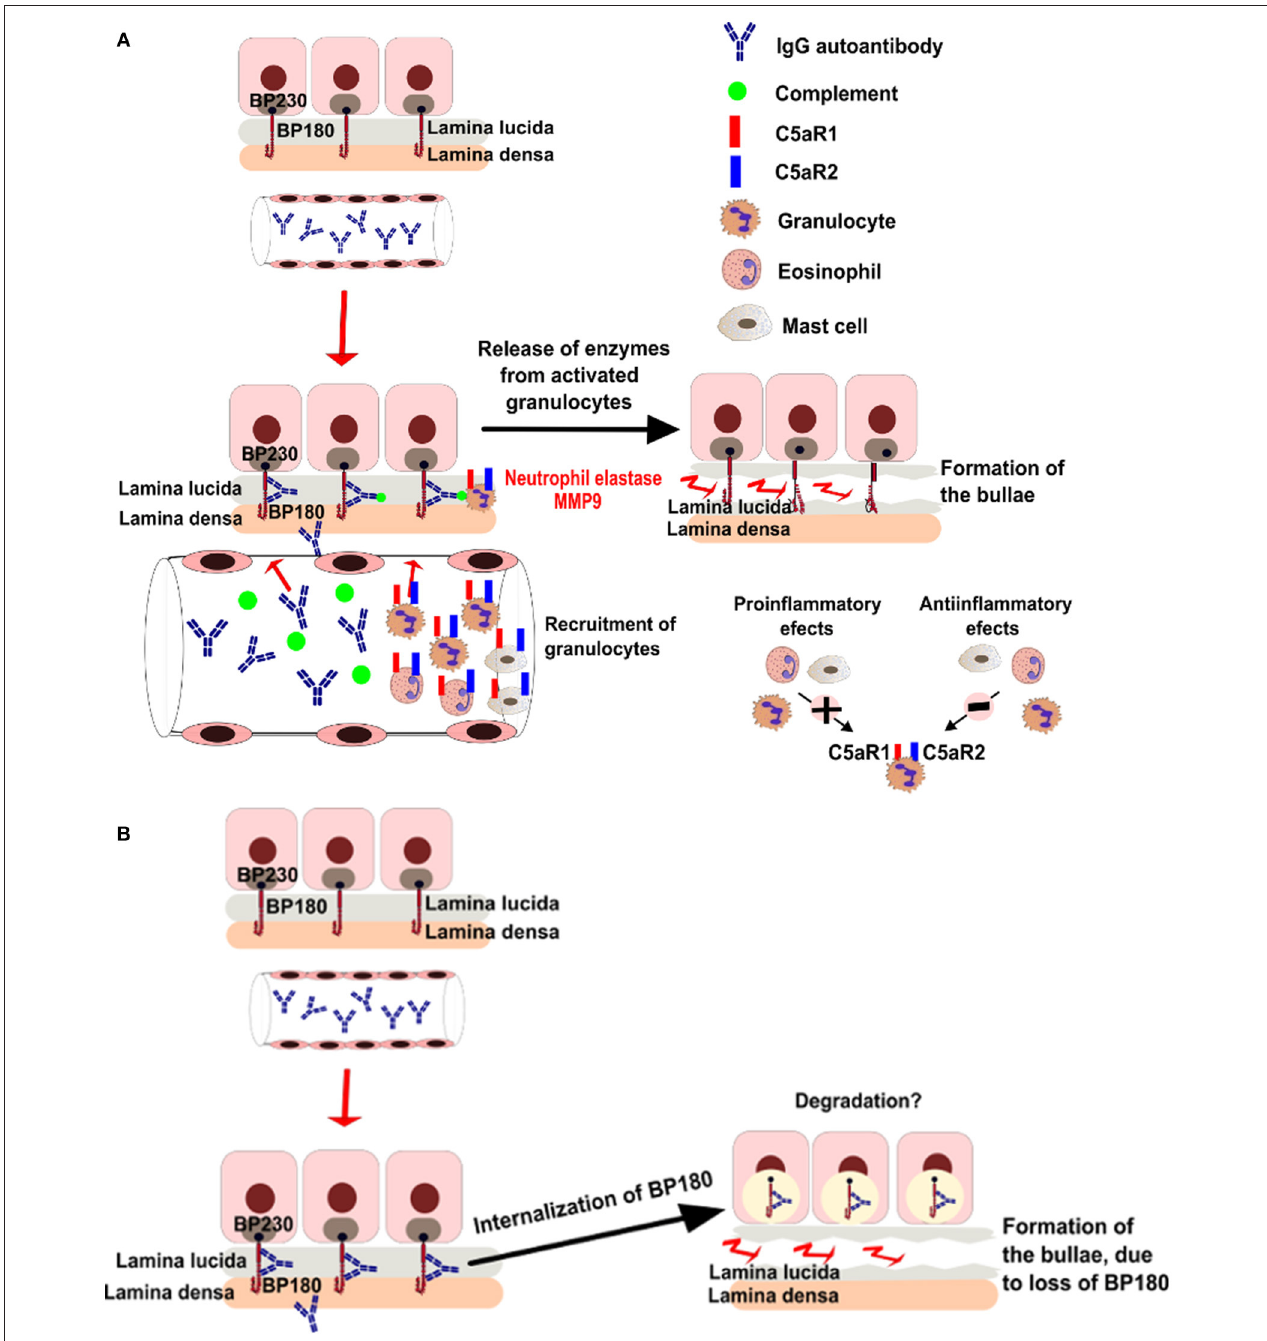
FIGURE 1 | Putative pathogenic mechanisms of blistering in bullous pemphigoid. (A) Complement dependent pathways of bullae formation. Binding of IgG autoantibodies at the dermal epidermal junction leads to complement activation and recruitment of neutrophils. Activated neutrophils release proteolytic enzymes, inducing dermal-epidermal separation. (B) Complement-independent pathways of bullae formation. Binding of IgG autoantibodies to BP180 leads to depletion of the protein by internalization.